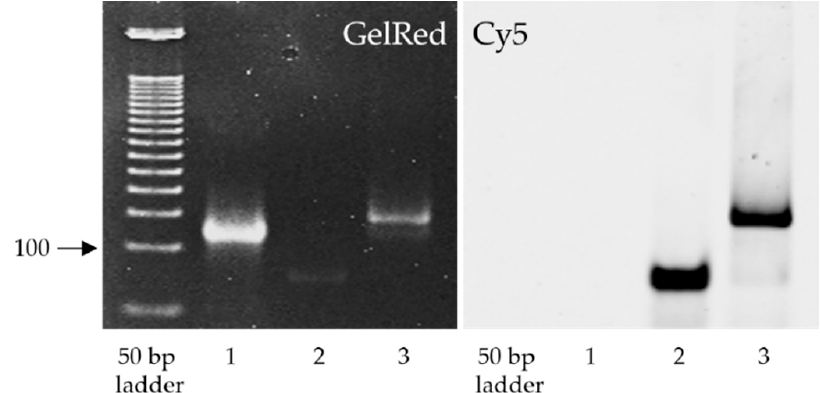
Figure 2. Binding of ASC1R to the target RdRp sequence. Lane 1, Control 119 nt RdRp sequence; Lane 2, Control ASC1R; Lane 3, ASC1R-RdRp heteroduplex. The polyacrylamide gel was imaged using filters for GelRed ( left ) and Cy5 ( right ).